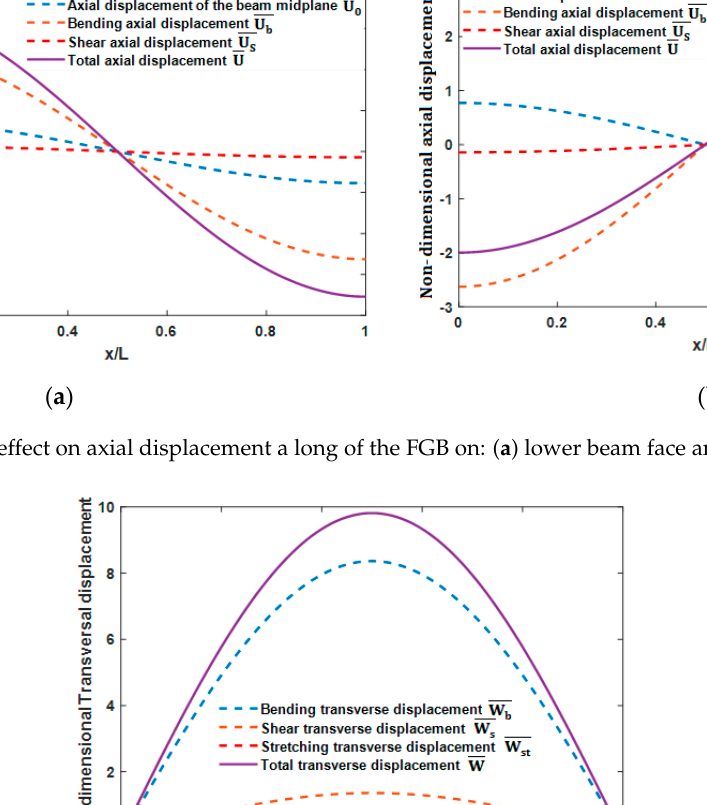
Figure 4. Thickness stretching effect on the non-dimensional transverse ( a ) and axial displacements ( b ).